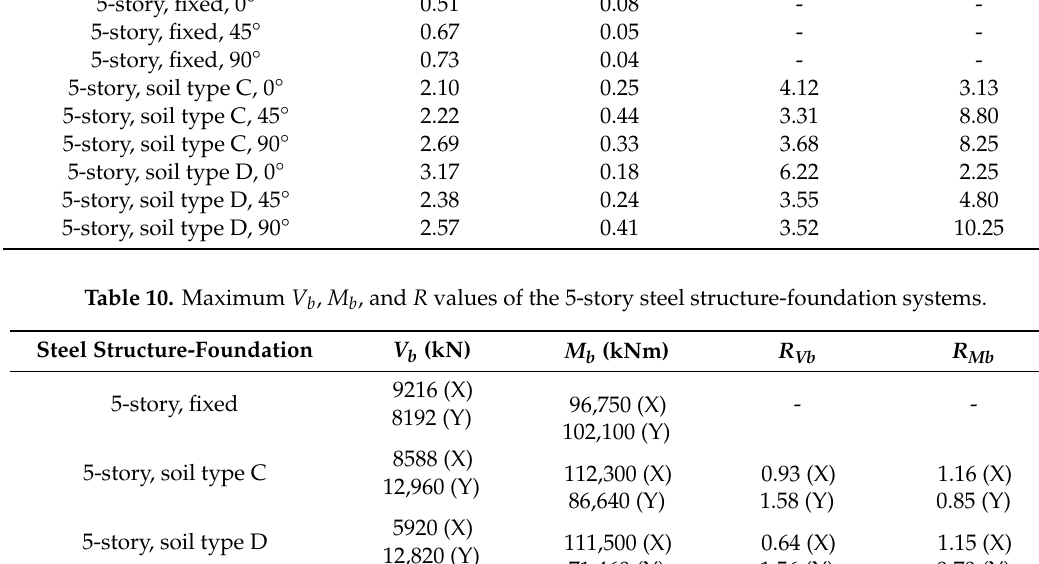
Table 9. Maximum IDR, RIDR, and R values of the 5-story steel structure-foundation systems. Steel Structure-Foundation, θ